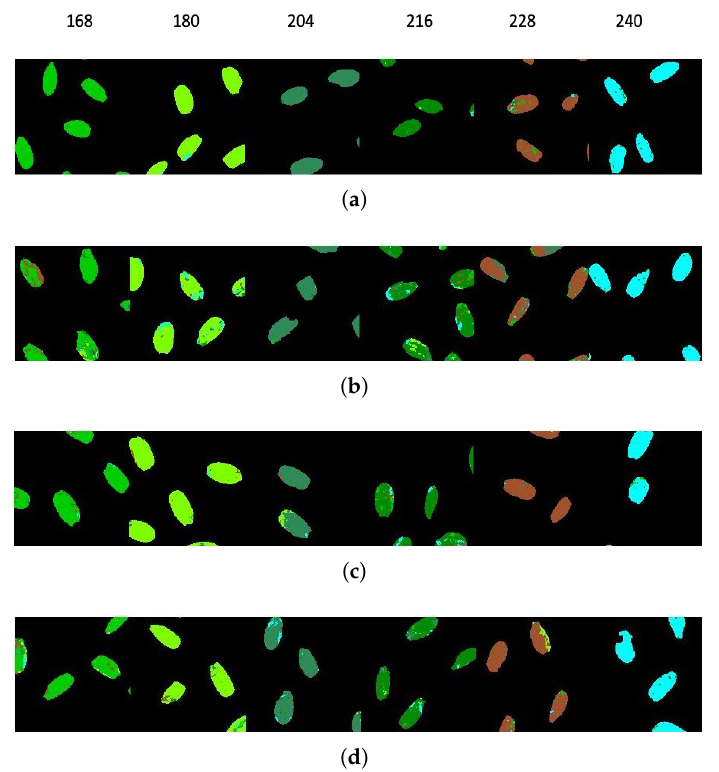
Figure 10. Classification map for rice HSI datasets for different temperature treatments: ( a ) HDT, ( b ) HDNT1, ( c ) HNT, ( d )